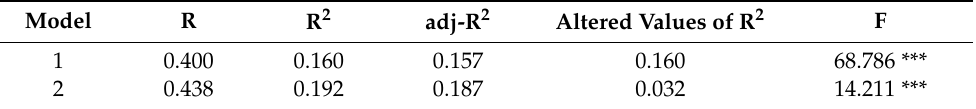
Table 4. Model calibration.